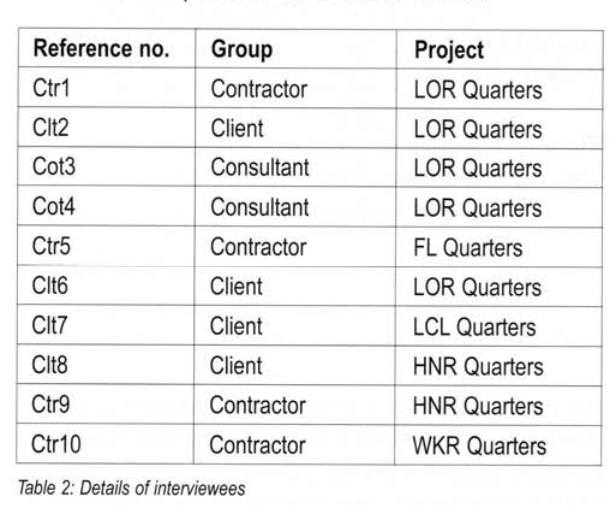
Table 2: Details of